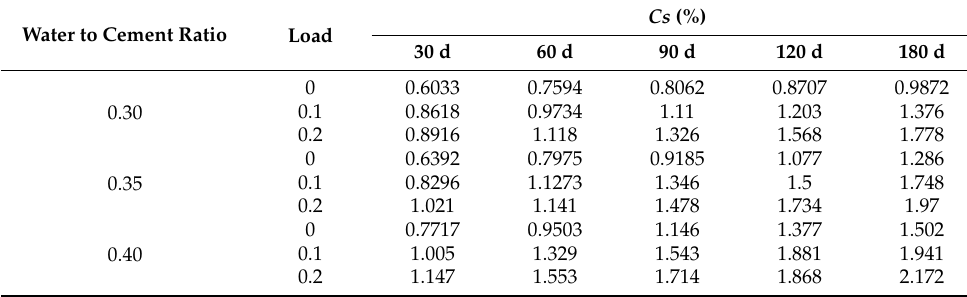
Table 8. Calculation results for C s